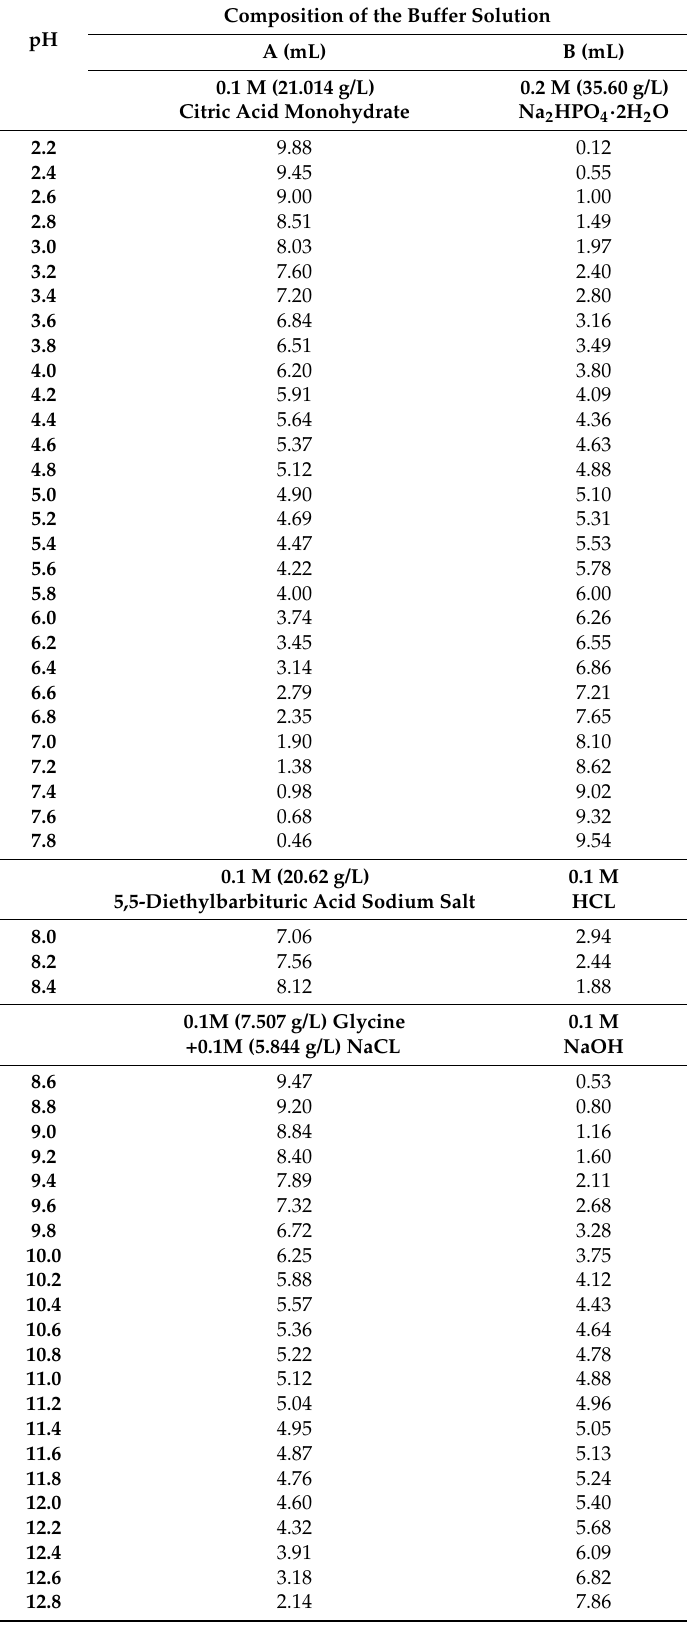
Table 2. Preparation of the required pH value from two stock solutions (A and